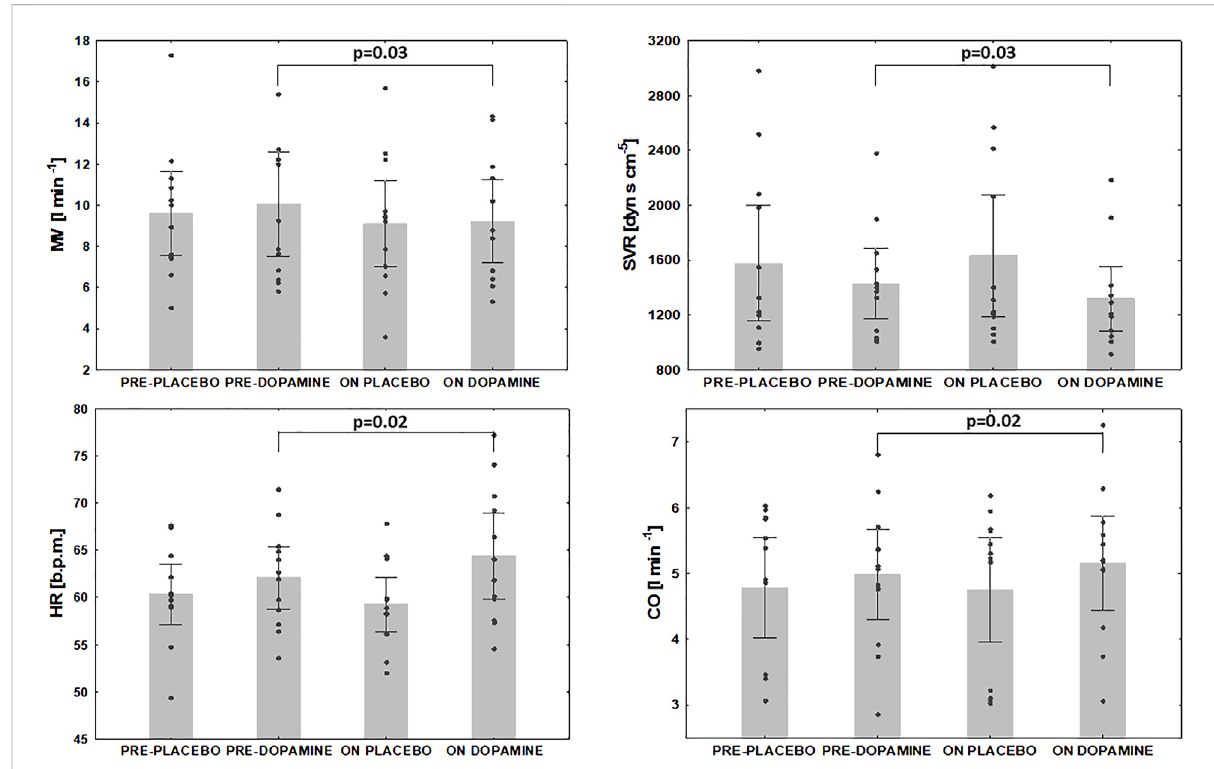
The effect of dopamine infusion on ventilation and hemodynamic indices under normoxia. MV- minute ventilation, SVR- systemic vascular resistance, HR- heart rate, CO- cardiac output.